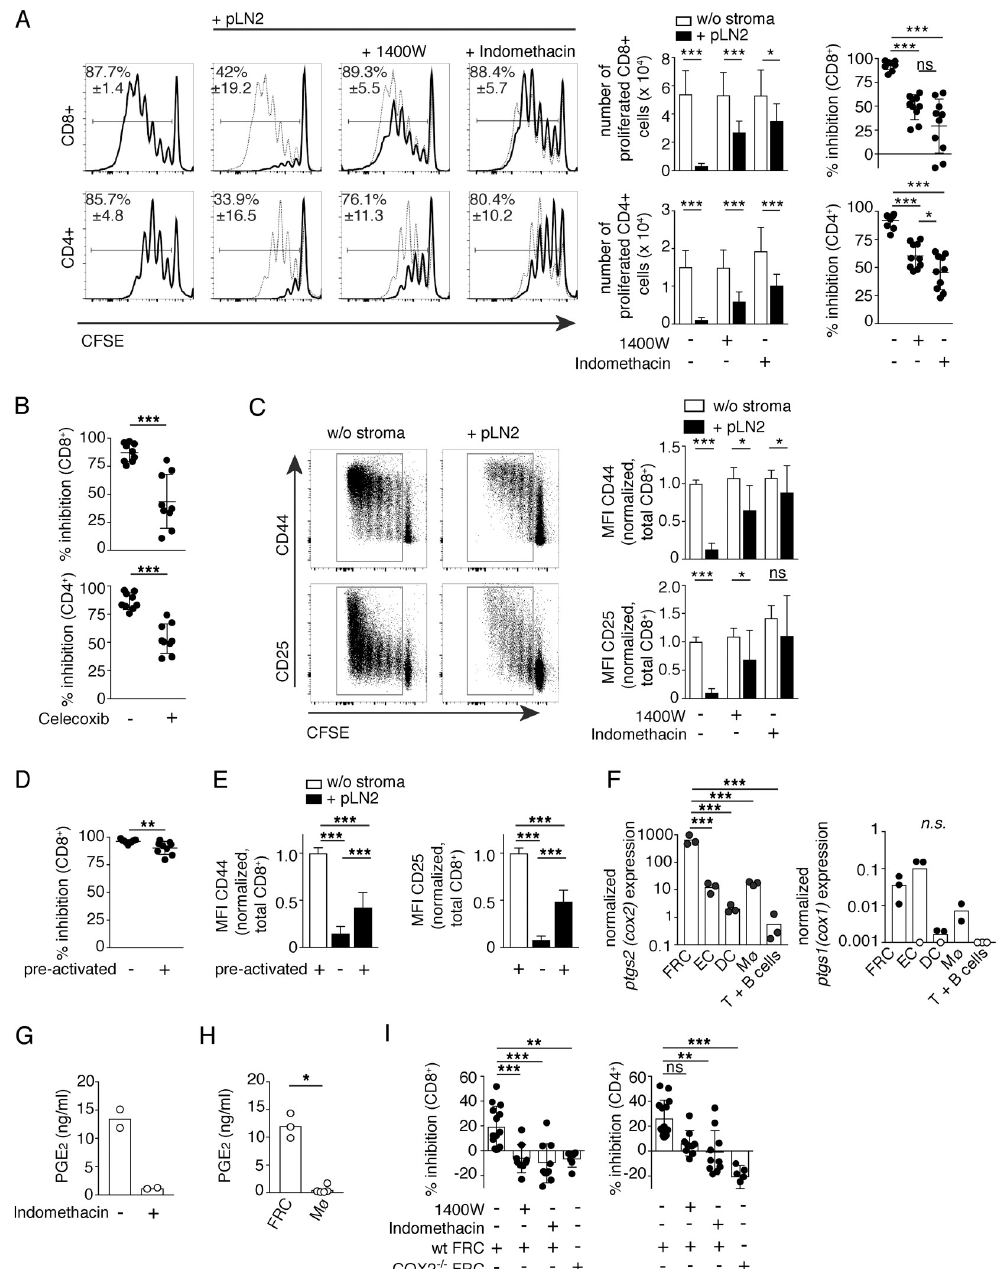
Fig 1. Na ï ve LN FRCs dampen CD8 and CD4 T-cell activation and proliferation by constitutive COX2 and PGE 2 expression. (A–E) CFSE-labeled T cells were activated nonspecifically with α CD3/28 DynaBeads and cultured in the absence or presence of pLN2 (pLN FRC cell line) and inhibitors, followed by flow cytometric analysis. (A–C) 3 d coculture of lymphocytes ± pLN2 ± inhibitor. (A) Shown on the left side are histograms of CD8+ and CD4+ T cells depicting CFSE dilution as readout of T-cell proliferation in presence (thick line) or absence (thin line) of FRCs ± iNOS inhibitor 1400W (3 μ M) or COX1/2 inhibitor indomethacin (10 μ M). Bar graphs in the middle indicate the number of proliferated CD8+ and CD4+ T cells. Scatter plots on the right side represent the percentage inhibition of T-cell proliferation mediated by FRCs, calculated based on the number of T cells 3 d after coculture. (B) Coculture of lymphocytes ± pLN2 ± celecoxib (5 μ M). Scatter plots depict the percentage inhibition of CD8+ and CD4+ T-cell proliferation in presence of pLN2. (C) Left side: dot plots showing CD44 or CD25 expression versus CFSE dilution among CD8+ T cells after coculture. Right side: bar graphs depicting the MFI of CD44 and CD25 on total CD8+ T cells with different data sets normalized to the untreated condition in absence of stroma (set at 1.0) to allow pooling of the data sets and better statistical analysis. Data shown in (A) and (C) represent four independent experiments ( n = 10). (D) CFSE-labeled T cells preactivated nonspecifically for 24